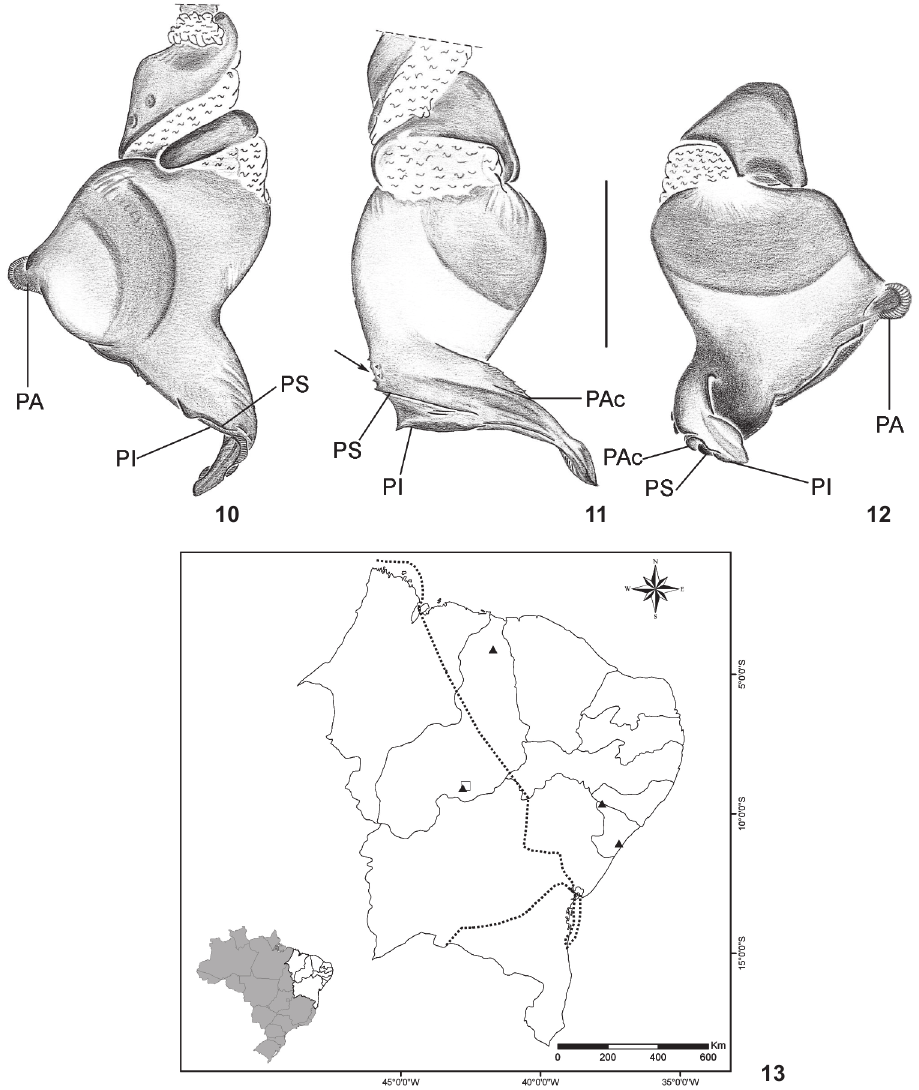
Figures 10-13. Actinopus tarsalis , male, 10-12 MPEG 11715: (10) copulatory bulb, prolateral; (11) copulatory bulb, dorsal; (12) copula- tory bulb, retrolateral – (PA) Paraembolyc apophysis, (Pac) Prolateral accessory keel, (PI) prolateral inferior keel, (PS) prolateral superior keel. Arrow: serrated surface on prolateral tegulum; (13) known distribution of Actinopus tarsalis . The black triangles represent the records from the present paper; the white square represents the record by L UCAS et al. (1978/1979). The dashed line indicates the approximated route of Spix & Martius expedition through northeastern Brazil, based on the information gathered by P APAVERO (1971). Scale bar: 1.0